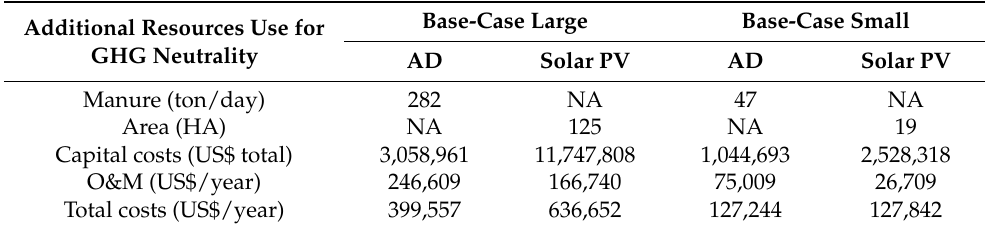
Table 4. Additional (only related to AD and PV capacity expansion) costs, area, and manure for the AD and solar PV systems needed to achieve GHG neutrality in the base-case